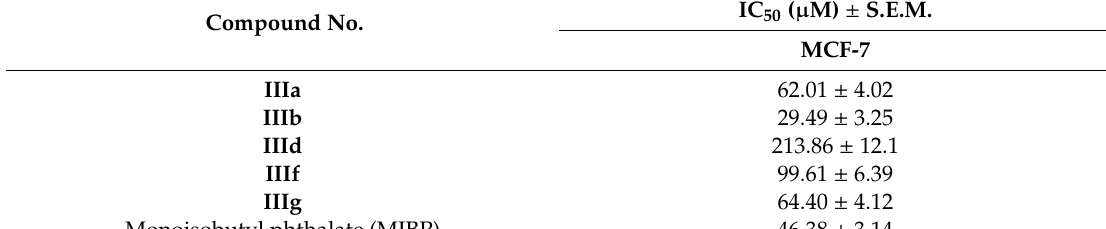
Table 3. In Vitro antiestrogenic activity of tested synthesized compounds IIIa,b , IIId , IIIf,g , and MIBP. Compound No.